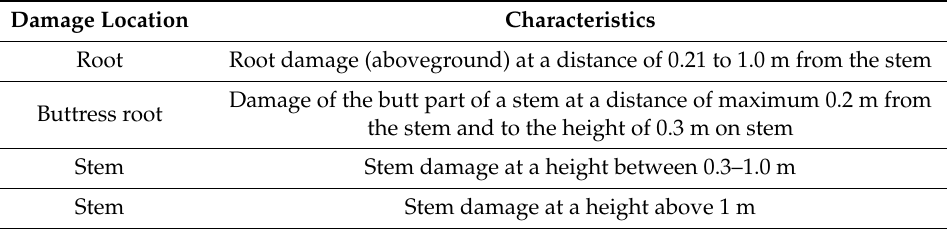
Table 3. Classification of damage location on the tree [29].